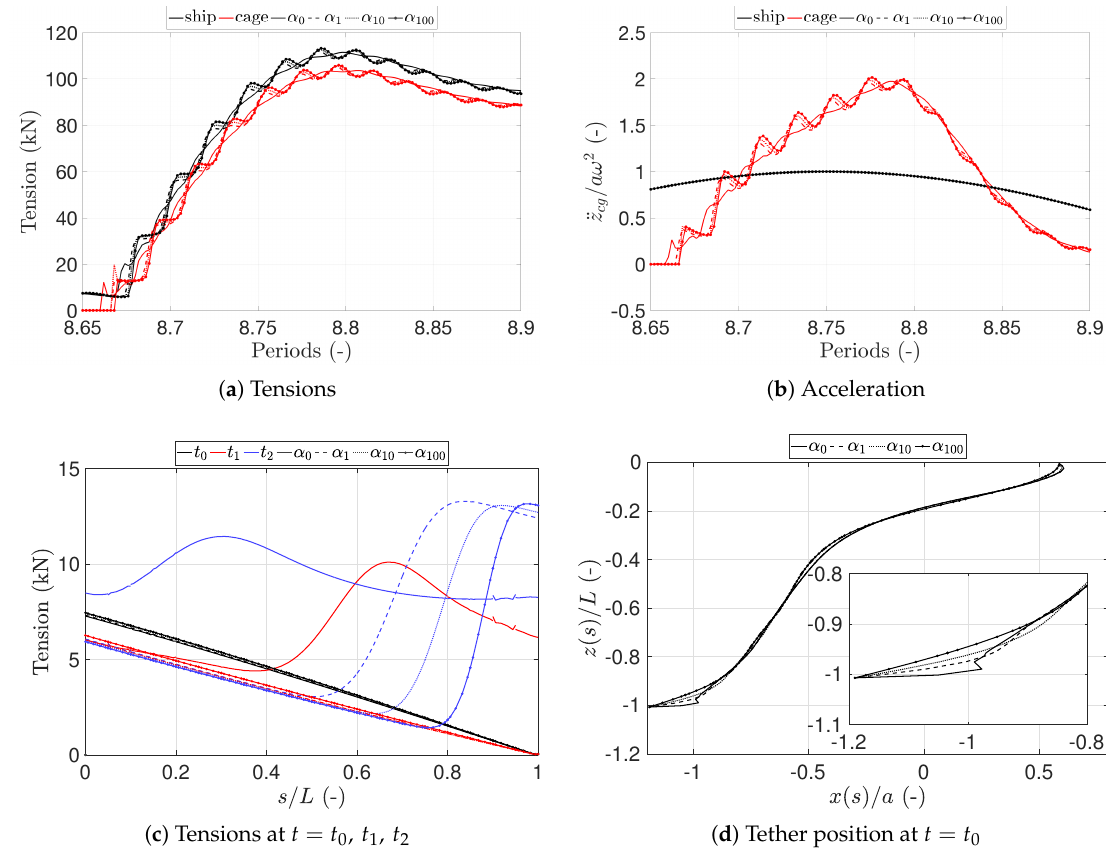
Figure 6. System behaviour shortly after snap load generation in L 200 , f = 0.2 Hz simulations. ( a ) Tension force at the two end-points and ( b ) vertical acceleration of the ship and the cage. In ( a ) and ( b ), the line-styles represent results from different bending stiffness factors α (denoted as grey in the legends), while the colour indicates results at the ship or cage, respectively. In ( c ), the snap load propagation along the cable is shown for t 0 = 8.65, t 1 = 8.665 and t 2 = 8.67 periods, and in ( d ), the cable position at t = t 0 = 8.65 periods is shown with the region close to the cage